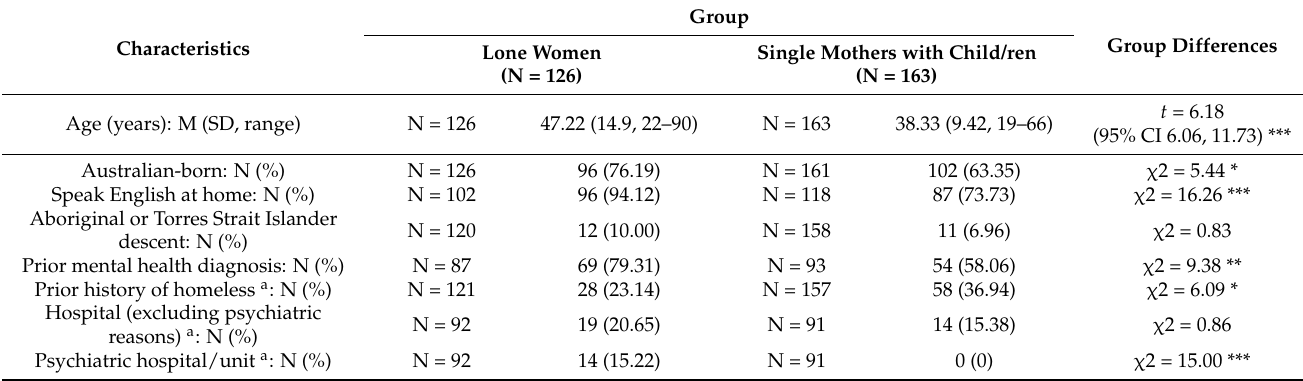
Table 1. Sociodemographic characteristics according to client group (N =